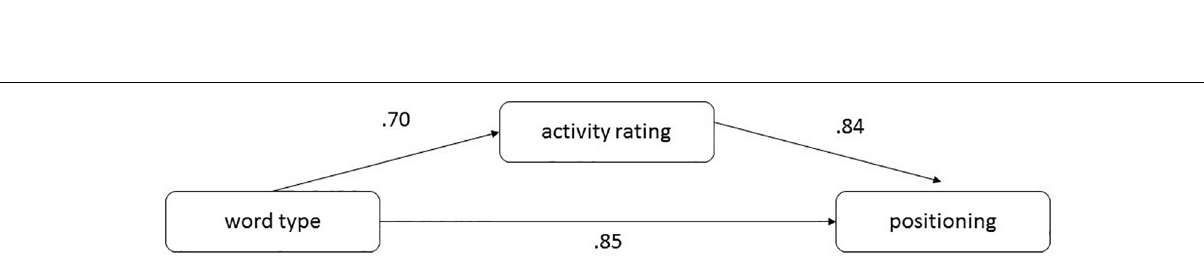
Frontiers in Psychology |